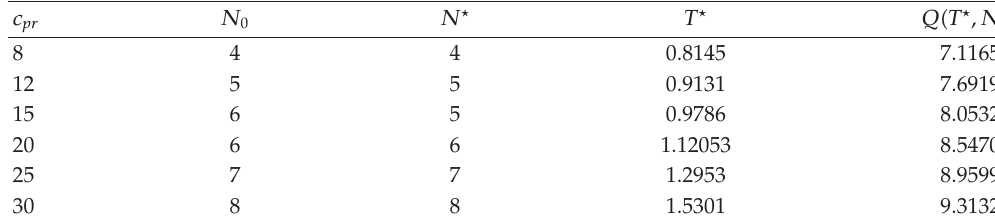
Table 2: N (cid:4) , T (cid:4) , Q (cid:6) T (cid:4) , N (cid:4) (cid:7) . Costs: c rj (cid:5) j , j (cid:5) 1 , 2 ... N − 1.